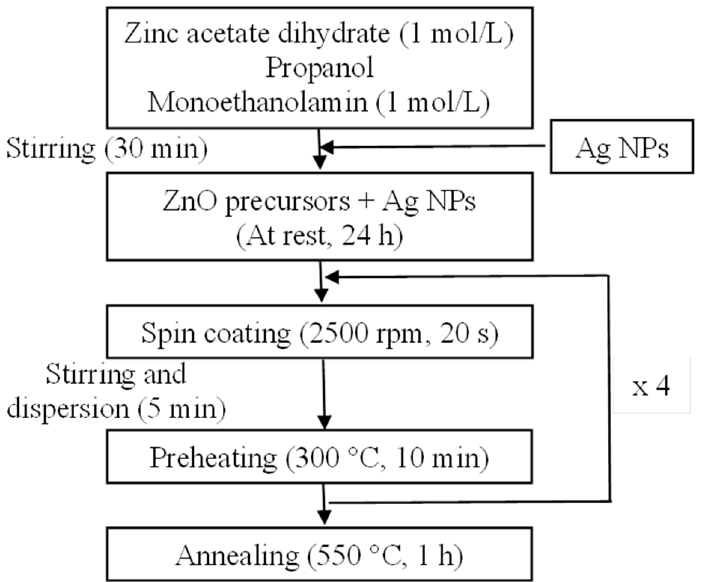
Figure 1. Sol–gel and spin-coating processing of ZnO nanocomposite films loaded with Ag NPs (ZnO/Ag(NPs)).